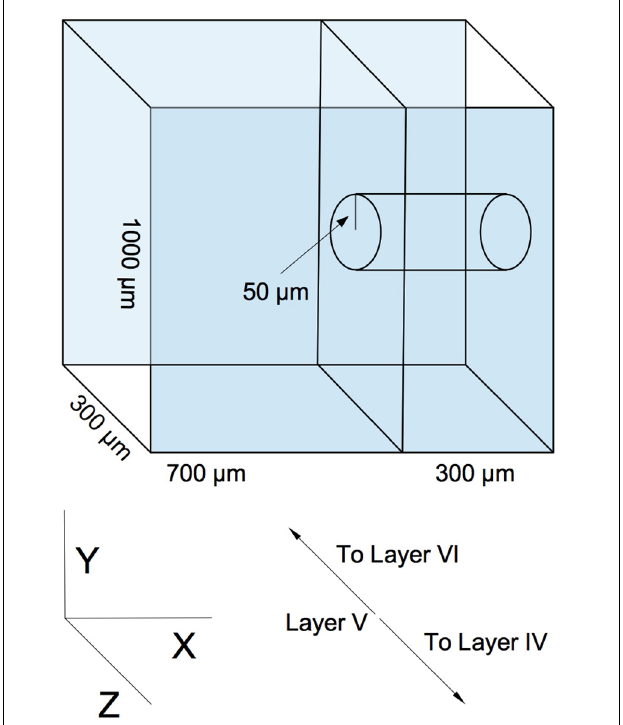
FIGURE 1 | An example of simulated slicing and sampling geometry, using a 300 µ m slice and a 50 µ m radius sampling